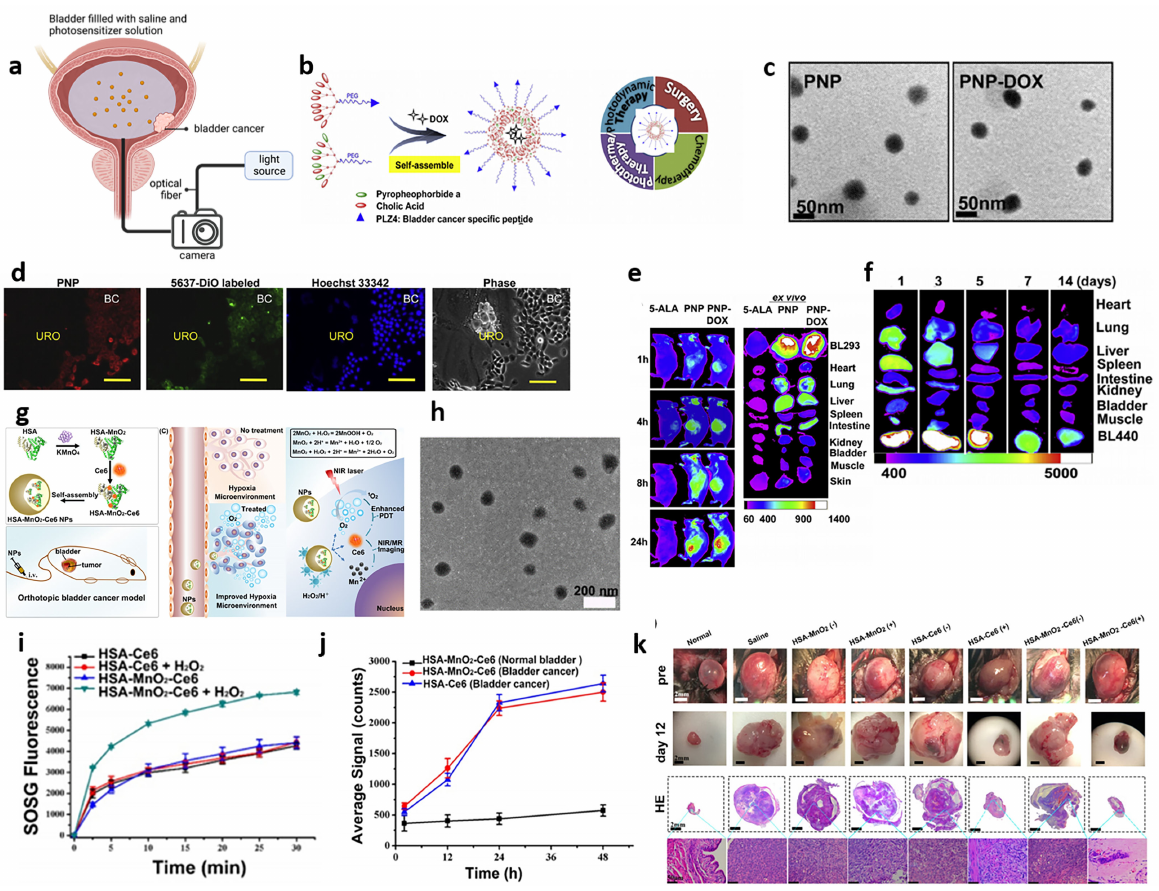
Figure 12. ( a ) Diagram of PDT following intravenously administered photosensitizers (Created with biorender.com). ( b ) Diagram of PNPs spontaneously assembled by the PEG 5k -Por 4 -CA 4 and PLZ4-PEG 5k -CA 8 . PLZ4-micelle (PM) was a mixture of PEG 5k -CA 8 and PLZ4-PEG 5k -CA 8 , while nanoporphyrin (NP) was a mixture of PEG 5k -CA 8 and PEG 5k -Por 4 -CA 4 . ( c ) PNPs and PNP-DOX transmission electron microscope images. ( d ) Fluorescence microscopic examination for the selective uptake of PNPs in the typically occurring canine bladder urothelial cells (URO: no fluorescence, substantial polygonal cells with lots of cytoplasm) co-cultured with 5637 bladder cancer cells (BC: DiO pre-labelled, green). ( e ) In vivo NIFR imaging of NSG mice bearing suBCutaneous PDX BL293 up to 24 h after injection of medication: 5-ALA (100 mg/kg), PNPs (5 mg/kg), and PNP-DOX (5 mg/kg and 2.5 mg/kg). ( f ) PNP-DOX biodistribution and tumor retention at different time points after injection. (Reprinted with permission Ref. [77]. Copyright © 2016 Elsevier Ltd.) ( g ) Schematic illustration of the synthesis of HSA-MnO2-Ce6 NPs and their utilization in enhanced PDT therapy for orthotopic bladder cancer by alleviating hypoxia. ( h ) TEM image of HSA-MnO2-Ce6 NPs. ( i ) O 2 production